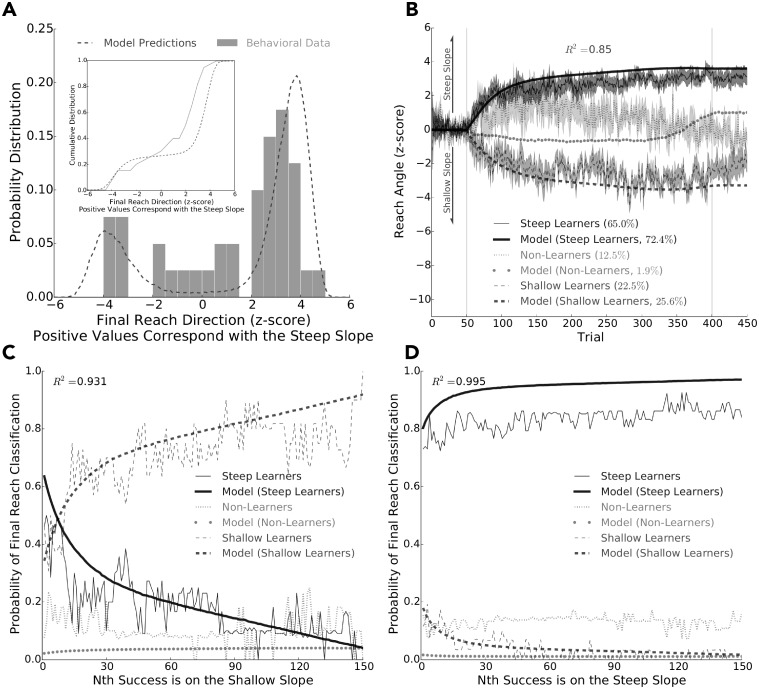
Simulations of Experiment 2 (using the best-fit parameters found in Experiment 1).A), B), C), D) We simulated 100,000 ‘individuals’ experiencing the steep clockwise reinforcement landscape with our learning model. A) Frequency (y-axis) of final reach direction (x-axis), the average of the last 100 reaches, of the behavioural data (bars) and model (dashed line). The inset shows the corresponding cumulative distribution. As shown, we found good agreement between the model and behaviour. B) Reach angle (y-axis) over trials (x-axis) for the behaviour data and model outputs. Here we display the combined behavioural data of participants that experienced the steep clockwise and steep counterclockwise reinforcement landscape (see Results for details). We partitioned participants into steep learners (thin solid line), shallow learners (thin dashed line), and non-learners (thin dotted line) based on their final reach behaviour. Using the same classification criteria, the model also produced steep learners (thick solid line) and shallow learners (thick dashed line) at similar frequencies, and to some extent non-learner (thick dotted line). The model did well to capture the average reach angles of the steep learners (n = 26) and shallow learners (n = 9). It did not do well to capture the reach angles of non-learners, however there were only five participants in this group. Overall, the average reach angles of the model and behavioural data were highly correlated (R2 = 0.86). The grey vertical lines separate baseline, experimental and washout trials. Shaded regions represent ± 1.0 SE. C) and D) show the probability of becoming classified as a steep learner, shallow learner, or non-learner based based on whether the Nth successful reach was on the shallow slope or steep slope, respectively. Again, the participants (solid lines) and model (dashed lines) behaved similarly. These data highlight the importance of early exploration on whether an individual will maximize reward when experiencing a complex reinforcement landscape.